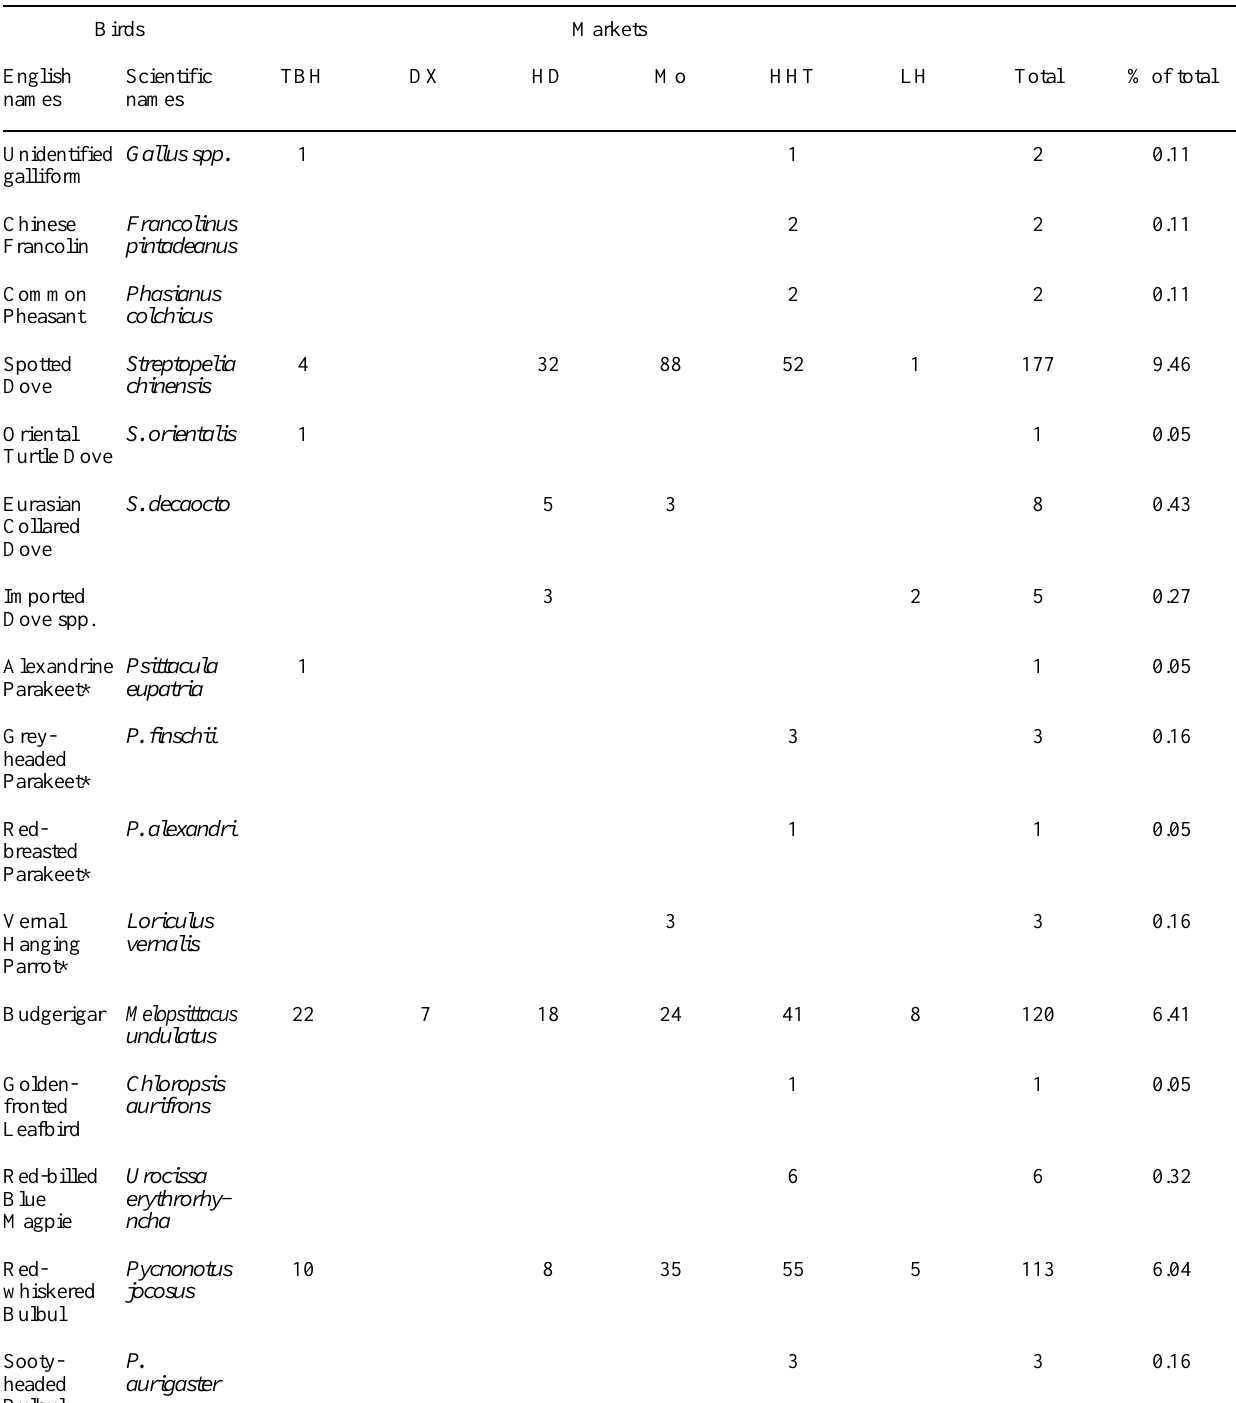
Table 1 . Species observed during the survey of Hanoi's bird markets in May 2007 (* denotes threatened IUCN status). The markets are abbreviated as follows: TBH stands for Tang Bat Ho; DX, Dong Xuan; HD, Hang Da; HHT, Hoang Hoa Tham; and LH, Lang